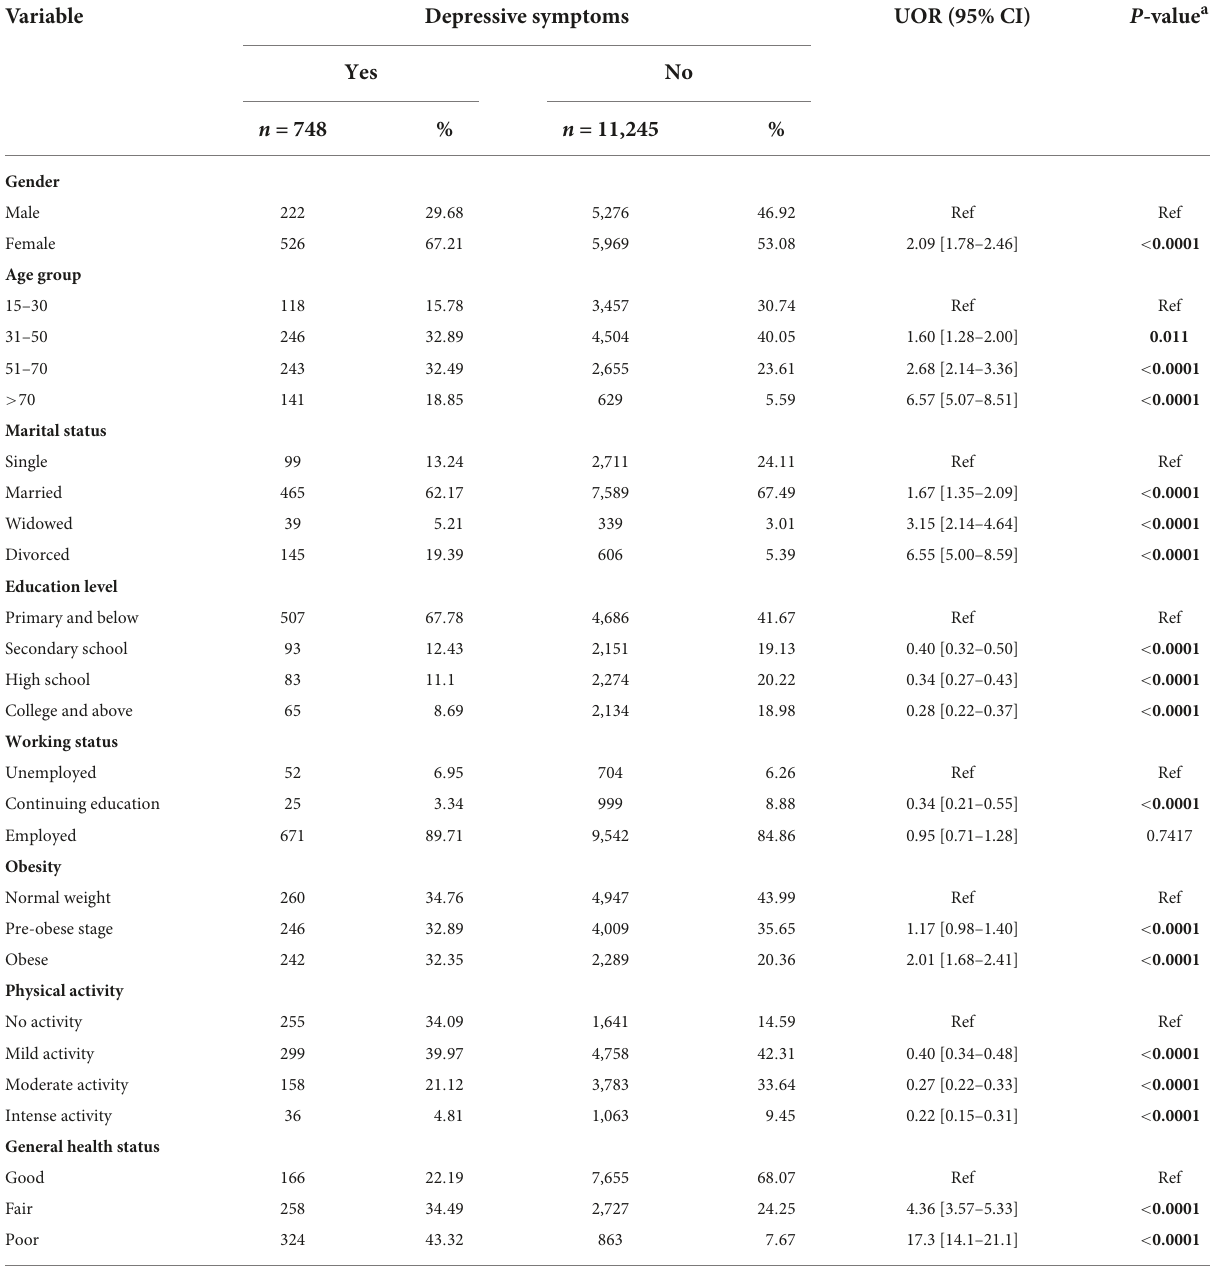
TABLE 1 Distribution of study characteristics by depressive symptoms. Variable Depressive symptoms UOR (95%